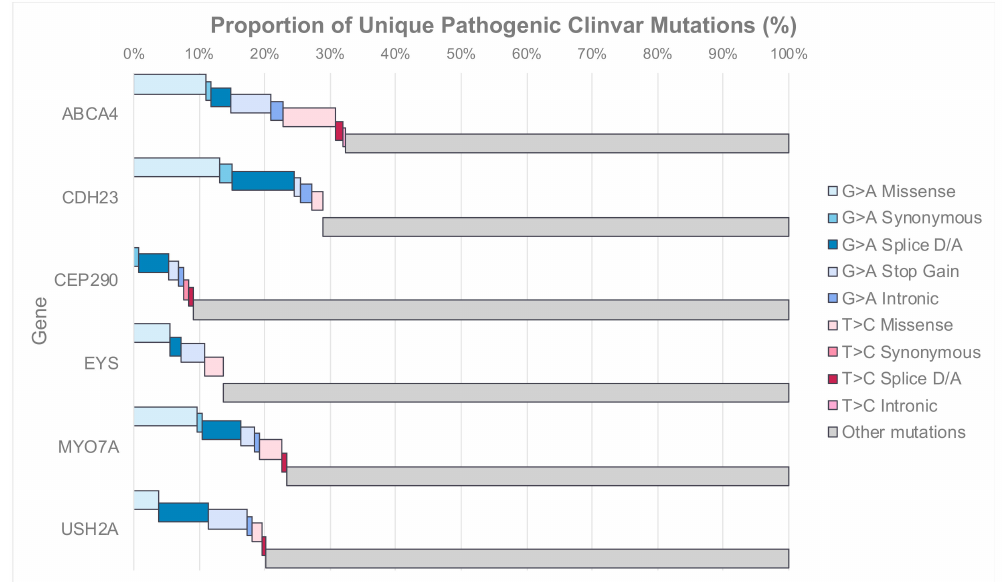
Figure 4. The distribution of unique “editable” mutations within all variants classed as “pathogenic” or “likely pathogenic” within the ClinVar Database. This includes all mutations including insertions, deletions and copy number variation, and these are included in “other mutations”. Blue bars represent G > A variants, while pink bars represent T > C variants. Accessed 3 October